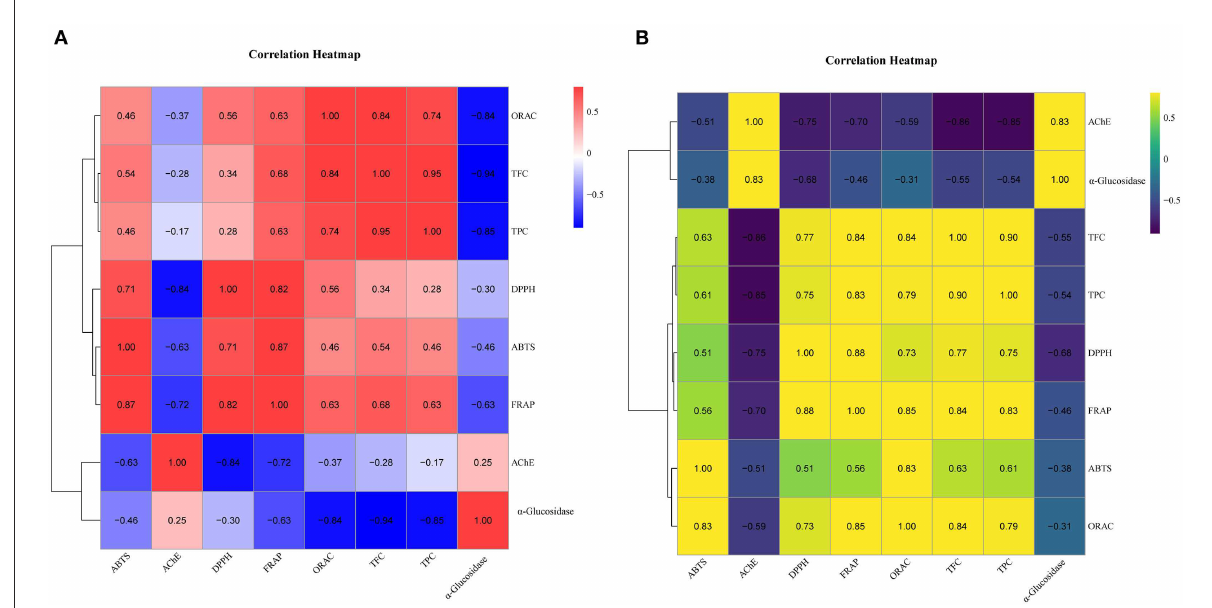
FIGURE2 The correlational analyses of experiment. (A) Heatmap of SOF correlation. (B) Heatmap of SOP correlation. The color represents the magnitude of correlation ( − 1 to 1). TPC, total phenolic content; TFC, total flavonoid content; DPPH, DPPH · scavenging activity; ABTS, ABTS · + scavenging ability; FRAP, the ferric reducing antioxidant power; ORAC, oxygen radical absorbance capacity; α -glucosidase, the IC 50 value for α -glucosidase inhibitory; AChE, the IC 50 value for acetylcholinesterase